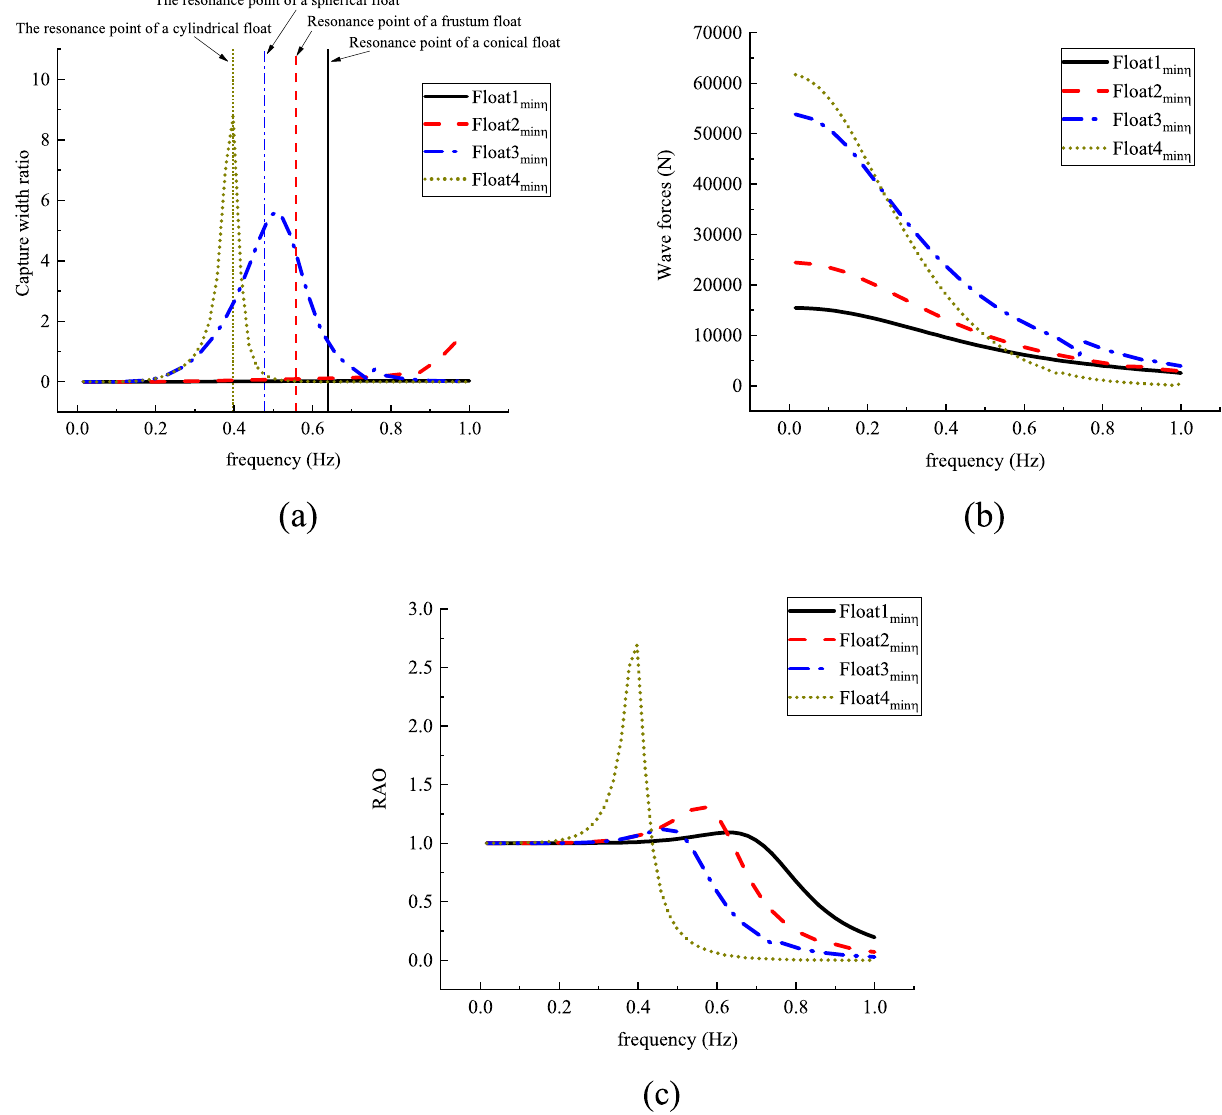
Fig. 4 Hydrodynamic characteristics of floats with different shapes at the minimum capture width ratio: a capture width ratio, b wave force, and c